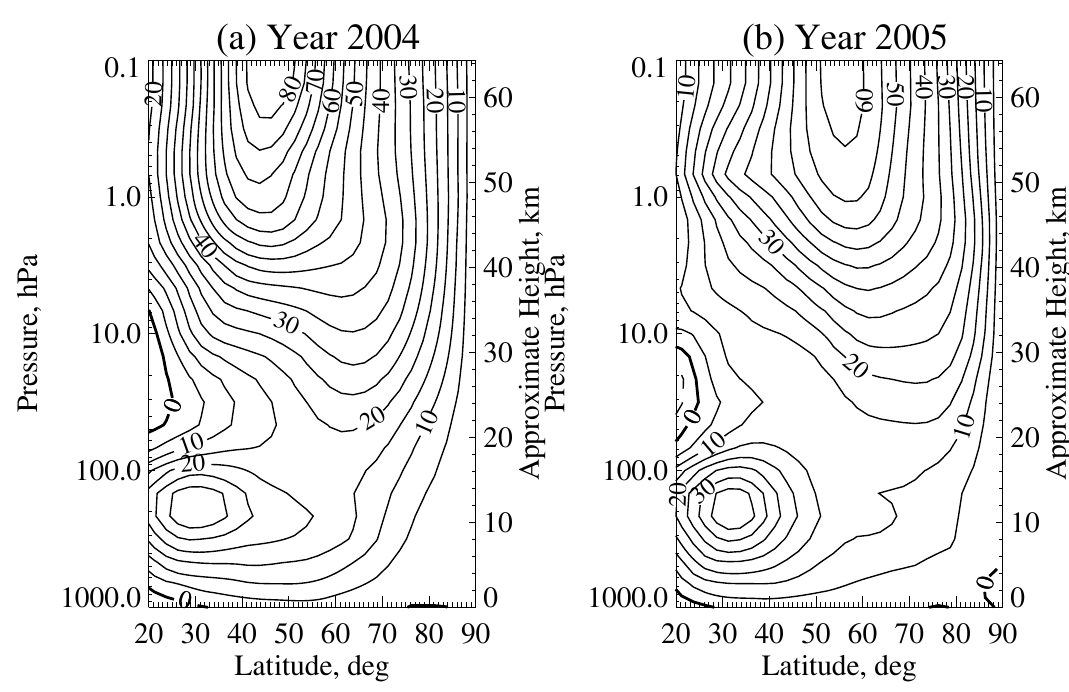
Fig. 9. Contour plots of wind (from MetO) for the November-December months of the winters of 2004/2005 and 2005/2006. The wind-values (positive numbers are westerly) are zonal-means of the zonal winds, in